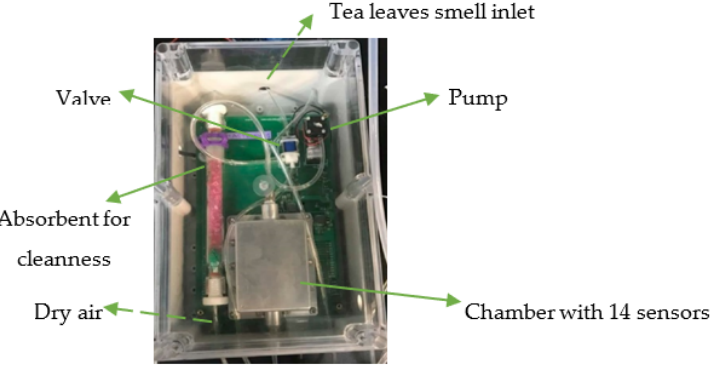
Figure 3. A developed gas-sensing system for smell discrimination and fermentation monitoring in the on-line production of oolong tea. The image was retrieved from Tseng et al. [58] with some modifications.